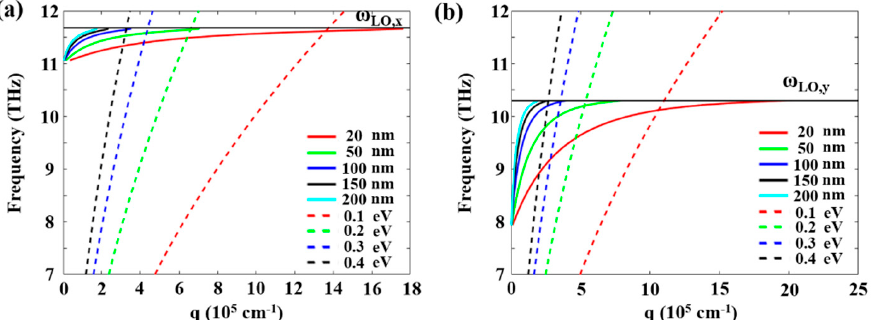
Figure 4. Analytical dispersion of polariton in graphene and α -MoO 3 . Dispersion of PhPs in bare slabs of α -MoO 3 with different thicknesses surrounded by vacuum (solid lines), as well as the dispersion of PPs in a graphene sheet surrounded by a semi-infinite air and a semi-infinite dielectric environment of α -MoO 3 for different Fermi energies (dashed lines). ( a ) Dispersion along [100] and ( b ) [001] crystal directions.